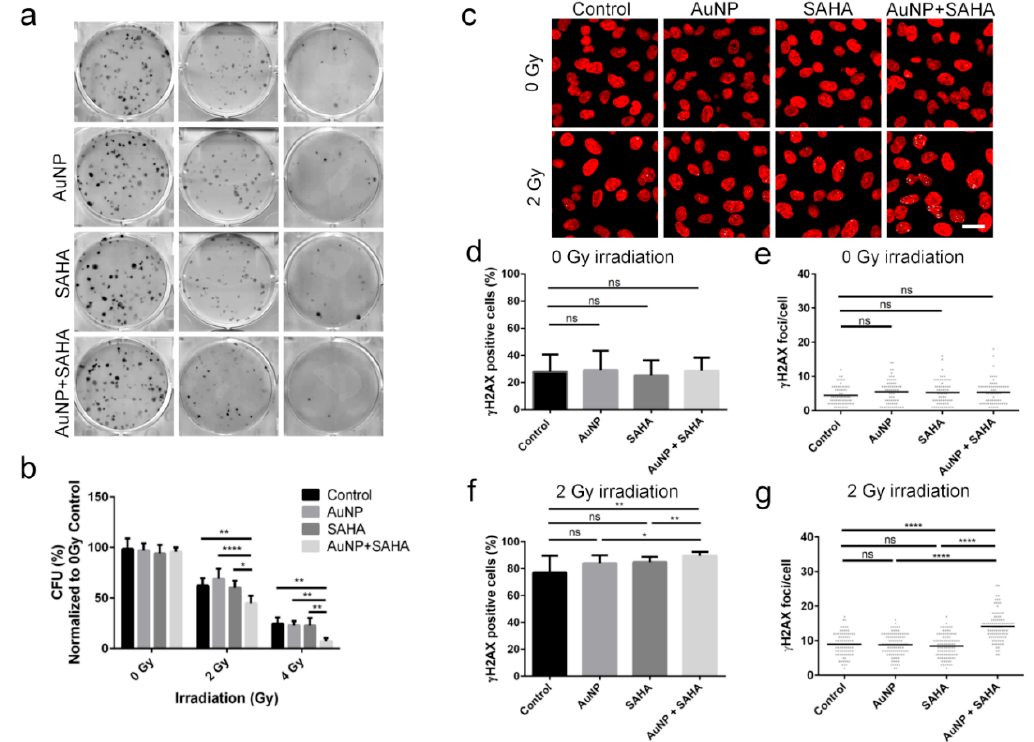
Figure 5. Radiosensitizing effect of AuNP and SAHA double treatments on A549 cells. ( a ) Figure5. Radiosensitizinge ff ectofAuNPandSAHAdoubletreatmentsonA549cells. ( a )Representative Representative pictures of the colonies of A549 cells upon AuNP, SAHA and AuNP + SAHA pictures of the colonies of A549 cells upon AuNP, SAHA and AuNP + SAHA treatments after 0, 2 and 4 Gy irradiation. ( b ) The colony forming capacity of A549 cells was significantly lower after the combinational treatments than in the untreated and in the AuNP- or SAHA-treated samples after 2 and 4 Gy dose irradiation. The applied concentrations of AuNP and SAHA did not a ff ect the colony forming capability of A549 cells without irradiation (* p value < 0.05; ** p value < 0.01; **** p value < 0.0001; two-way ANOVA Tukey’s multiple comparisons test). ( c ) Representative confocal microscopy images of the γ H2AX-stained non-irradiated and irradiated A549 cells upon AuNP, SAHA and AuNP + SAHA treatments. ( d ) No di ff erences were observed in the number of γ H2AX-positive cells ( e ) or in the γ H2AX foci / positive cells upon AuNP, SAHA and AuNP + SAHA treatments after 0 Gy irradiation. ( f ) The percentage of γ H2AX-positive cells and ( g ) the number of γ H2AX foci counted in the positively stained cells were significantly higher after AuNP + SAHA double treatments compared to the control and to the individual treatments after 2 Gy irradiation. Scale bar represents 20 µ m. (* p value = 0.0163; ** p value < 0.01; **** p value < 0.0001 Unpaired t